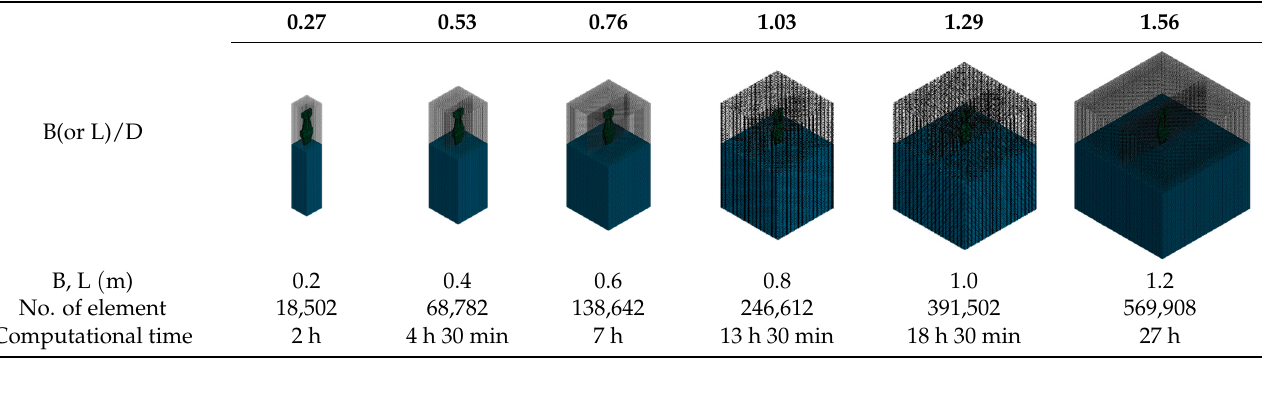
Table 8. The various domain size of fluid.